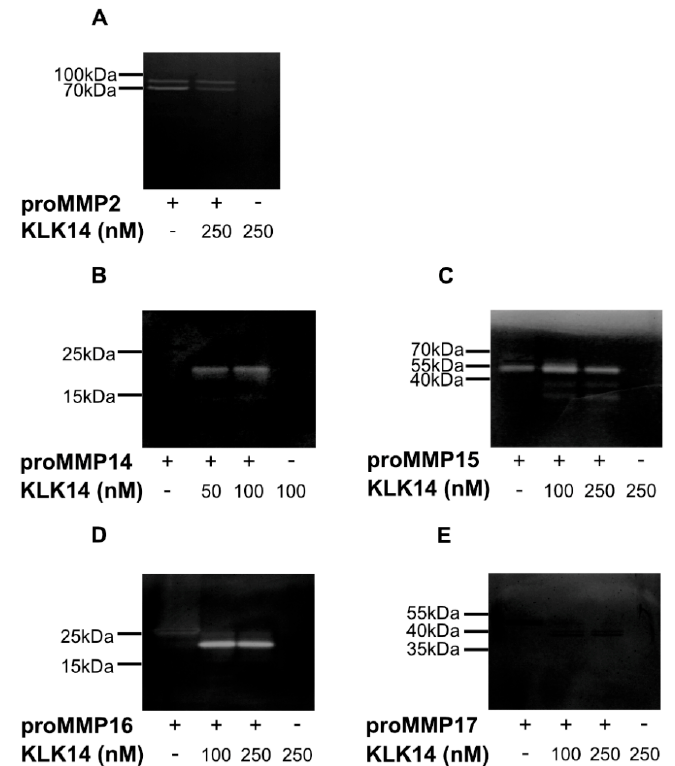
Figure 4. Gelatin zymography of proMMPs by KLK14-mediated processing. Activation of proMMPs